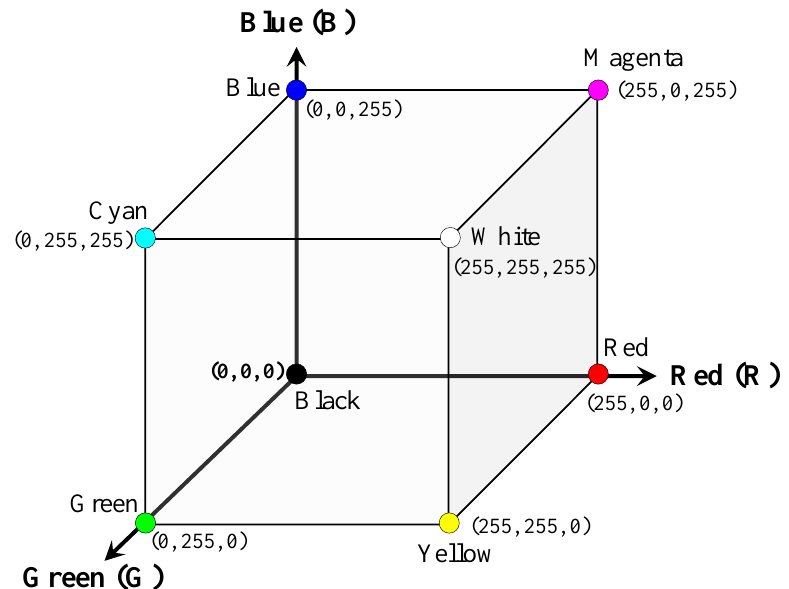
Figure 1. Three-dimensional RGB color space.